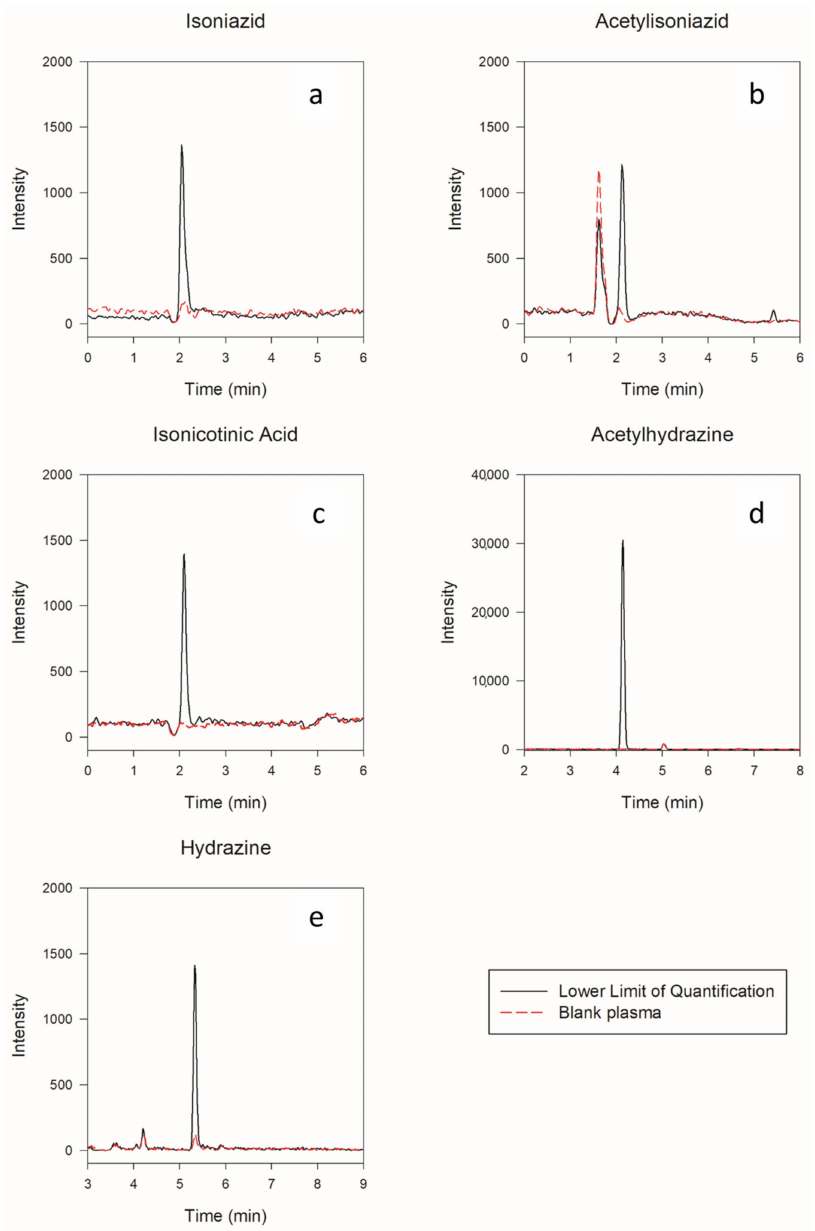
Figure 2. Chromatogram of all analytes in LLOQ compared to blank plasma. There were no significant interferences at the time of the analyte’s elusion in blank plasma, indicating the method is specific for each analyte: ( a ) isoniazid LLOQ compared to blank plasma; ( b ) acetylisoniazid LLOQ compared to blank plasma; ( c ) isonicotinic acid LLOQ compared to blank plasma; ( d ) acetylhydrazine LLOQ compared to blank plasma; ( e ) hydrazine LLOQ compared to blank